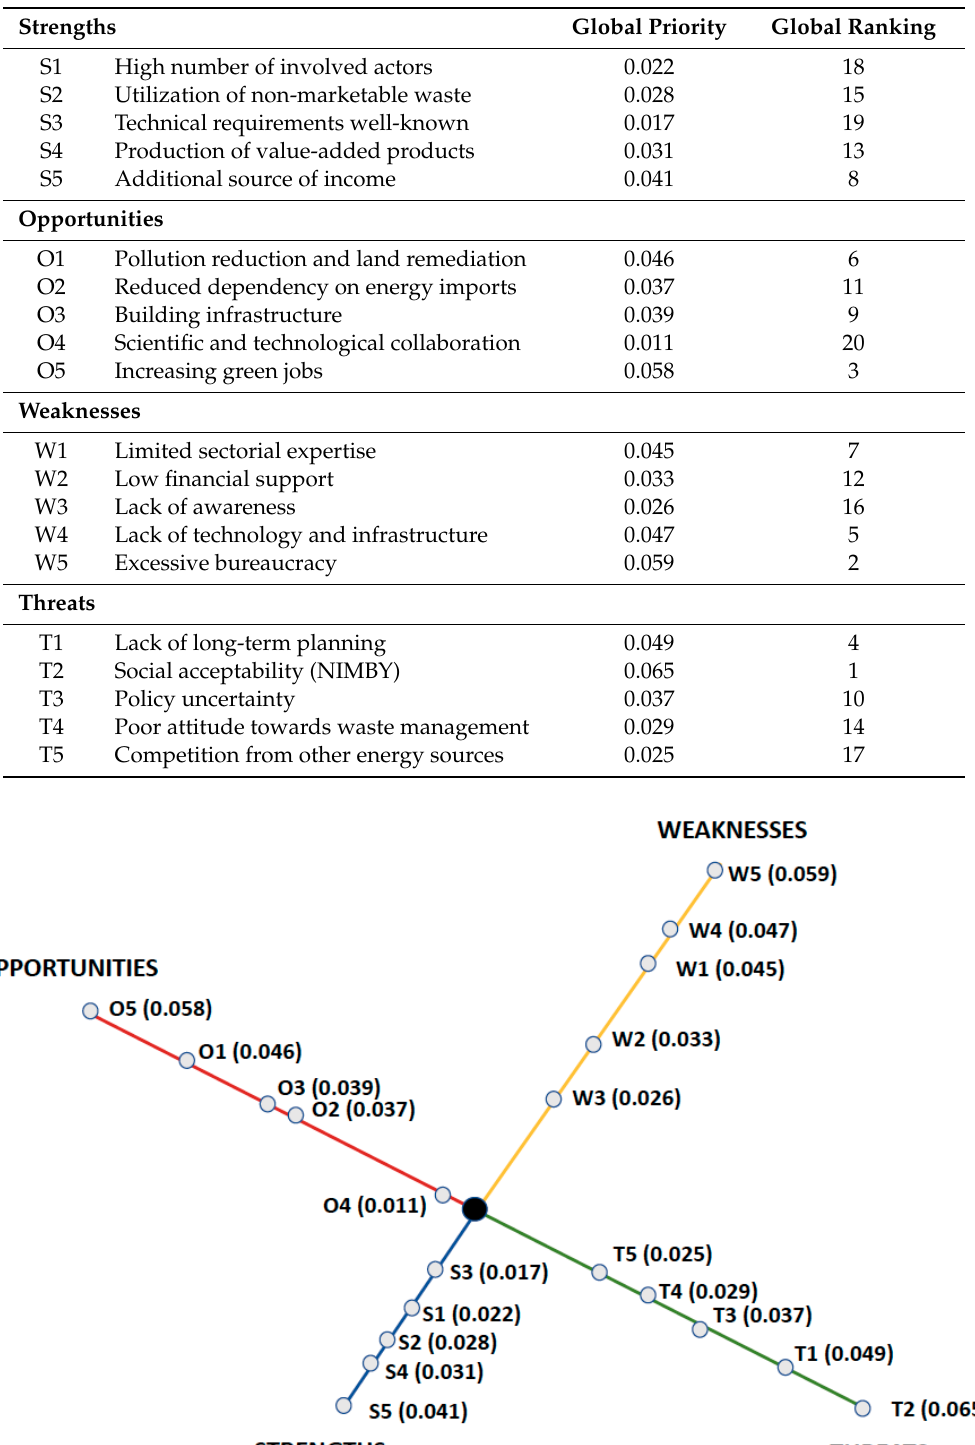
The global priorities for SWOT factors determined through Strengths, Weaknesses, Opportunities and Threats–Analytic Network Process (SWOT-ANP).